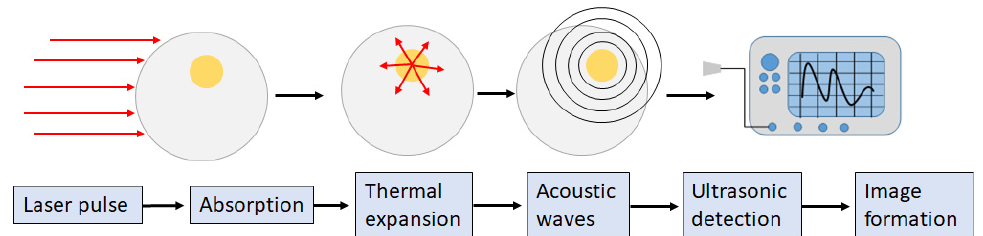
Fig. 2. Principle of